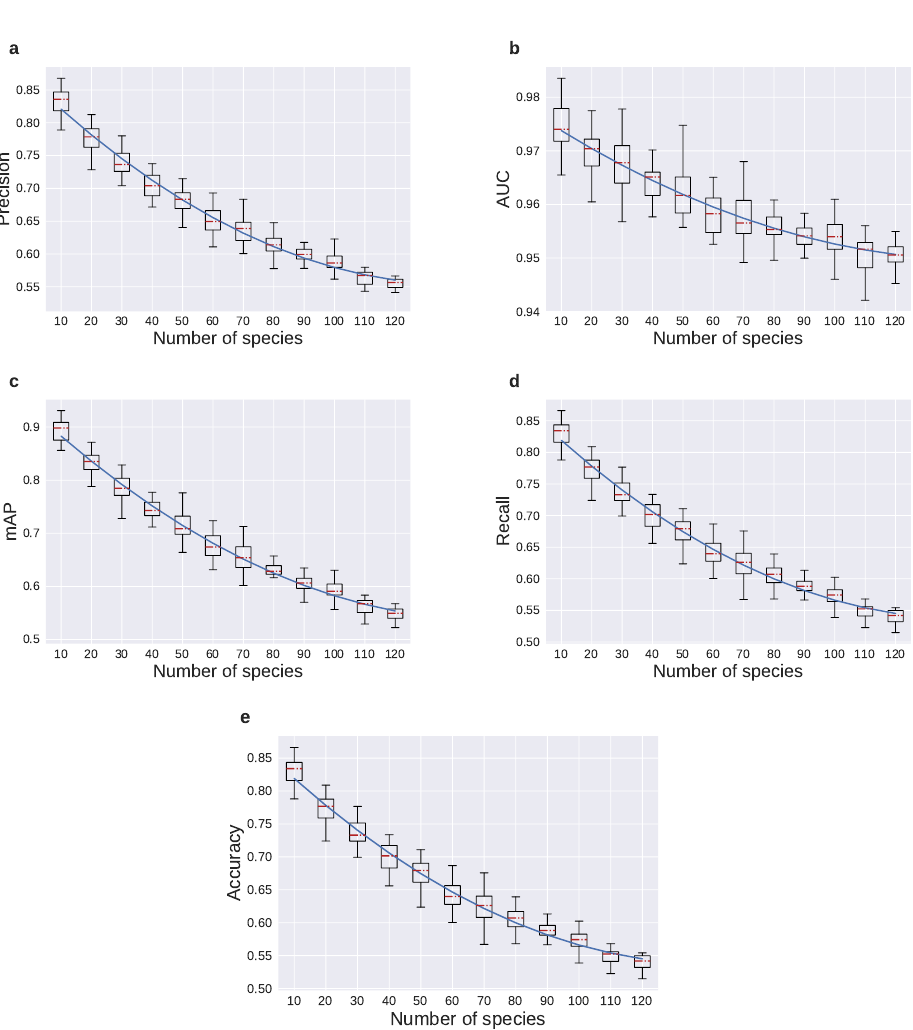
Figure 4. The n -dependence of ( a ) Precision, ( b ) AUC, ( c ) mAP, ( d ) Recall and ( e ) Accuracy can be described by fitting quadratic functions (line). The error bars (whiskers) represent the ranges from the best result to worst result obtained for 20 different randomly drawn subsets for each value of n . The red marking in each box indicates the median, and the boxes show the range of the middle 50% of the